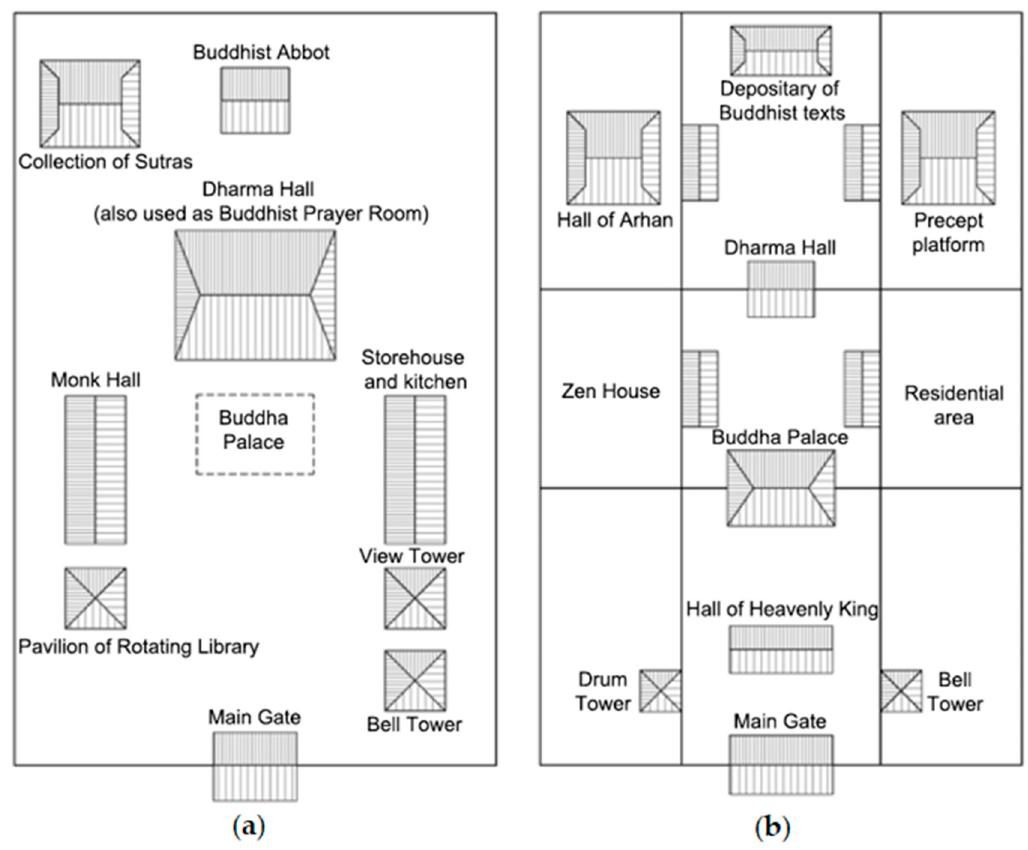
Figure 1. Layout of Buddhist temples in ancient China. ( a ) Layout during the Song dynasty. ( b ) Layout during the Qing dynasty.